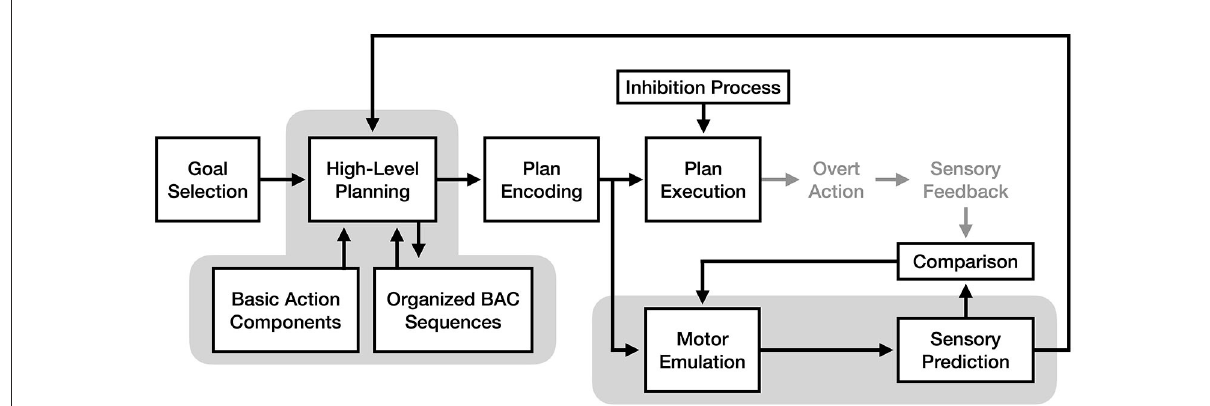
FIGURE7 A fusion model of motor imagery combining the motor emulation theory’s forward model mechanism with the perceptual-cognitive model’s cognitive reorganization and chunking mechanism. The components of the model responsible for the experience of motor imagery are enclosed in gray.